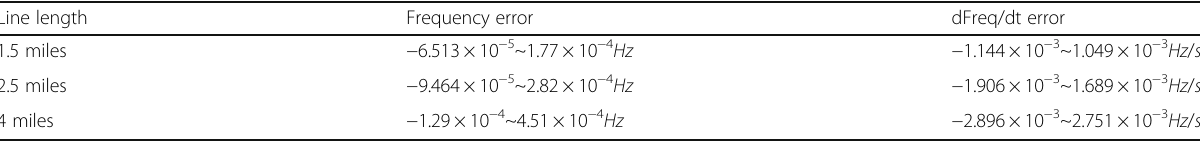
Table 5 Estimation error of frequency and rate of frequency change with different lengths of the line Line length